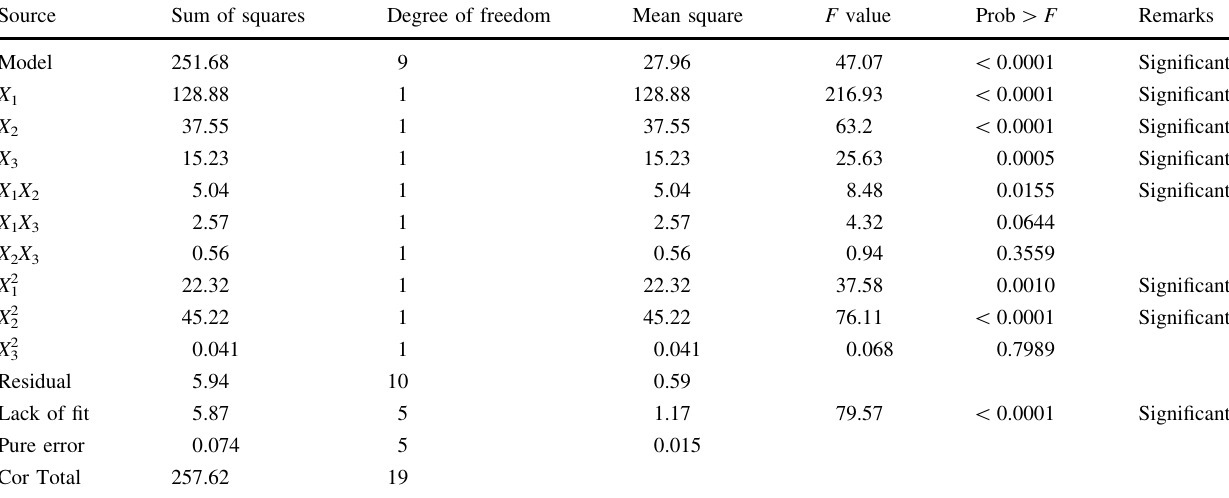
Table 4 Analysis of variance (ANOVA) for response surface quadratic model for CO 2 removal efficiency (%) Source Sum of